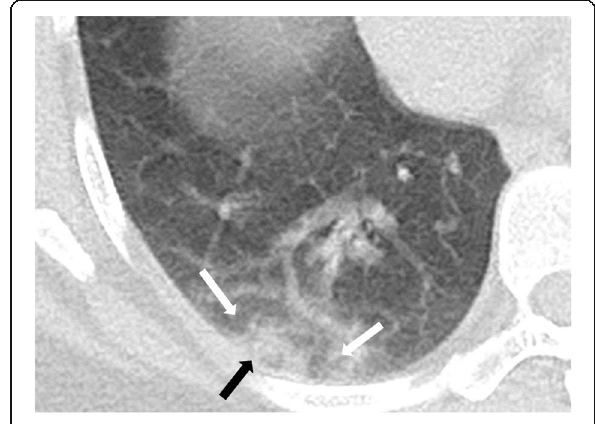
Fig. 2 Halo sign: ill-defined focus of consolidation (black arrow) is surrounded by a rim of GGO (black arrow). Various entities can give a halo sign; hence, it is rather a nonspecific